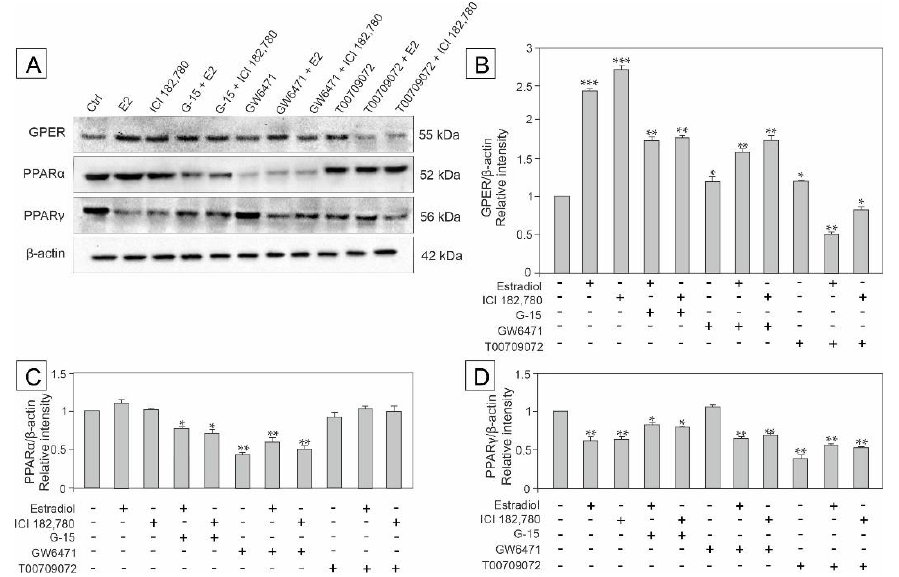
Figure 4. The effect of estradiol (E2), GPER agonist (ICI 182,780), GPER antagonist (G-15), PPAR α antagonist (GW6471), and PPAR γ antagonist (T00709072) on GPER, PPAR α and PPAR γ protein expression in MA-10 cells ( A – D ). Representative blots of Western analysis ( A ) and relative expression of the proteins ( B – D ). Cells were harvested after 24 h. Untreated cells served as a control. Protein levels within control cells were given a value of 1. The cropped blots are displayed and the original blots are provided in Supplementary Materials (Figure S1). The relative levels of the proteins were normalized to β -actin, which served as the internal protein loading control. The histograms are the quantitative representation of data (mean ± SD) of three independent experiments, each in triplicate ( B – D ). A plus sign (+) indicates the presence of the compound in the culture medium, a minus sign ( – ) indicates no compound in the culture medium. Asterisks indicate significant differences from control cells. Values are denoted as * p < 0.05, ** p < 0.01 and *** p < 0.001.